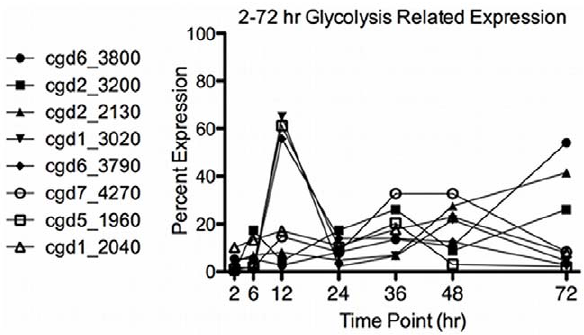
Figure 8. Glycolysis Related Transcripts. The relative expression using 2-72 hr data is graphed for the annotated enzymes involved in glycolysis.